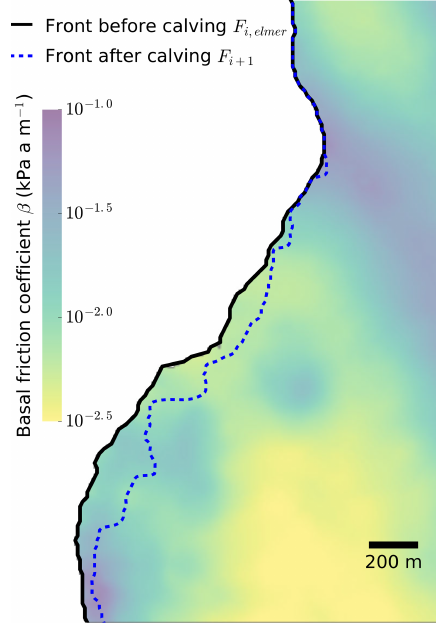
Figure 5. Basal friction coefficient, β , and new position of the front, F i + 1 , after calving from the HiDEM simulation generated through the UNICORE-based